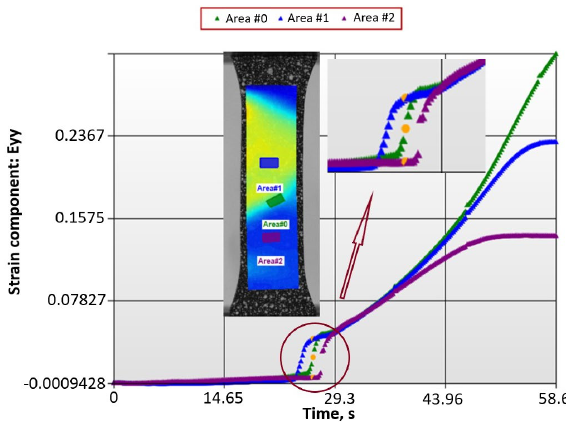
Figure 4. Strain determination behind, in front of and at the Lüders band